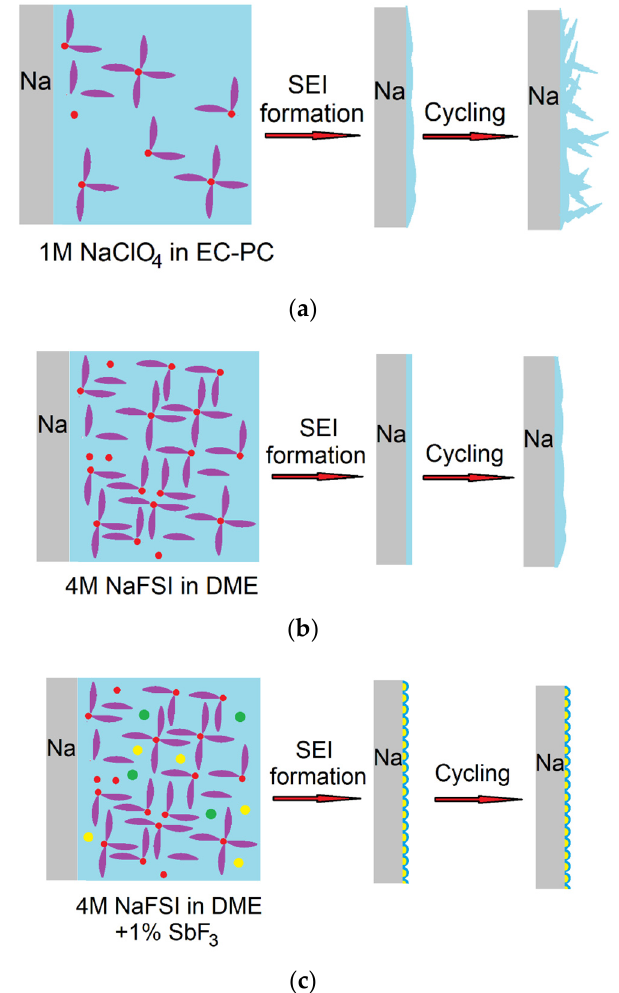
Figure 3. SEI effect on dendrite formation in various electrolytes. ( a ) a common electrolyte (1 M NaClO 4 in EC ‒ PC mixture), ( b ) high concentration imide electrolyte (4 M NaFSI in DME), ( c ) high concentration imide electrolyte with the addition of 1% SbF 3 .